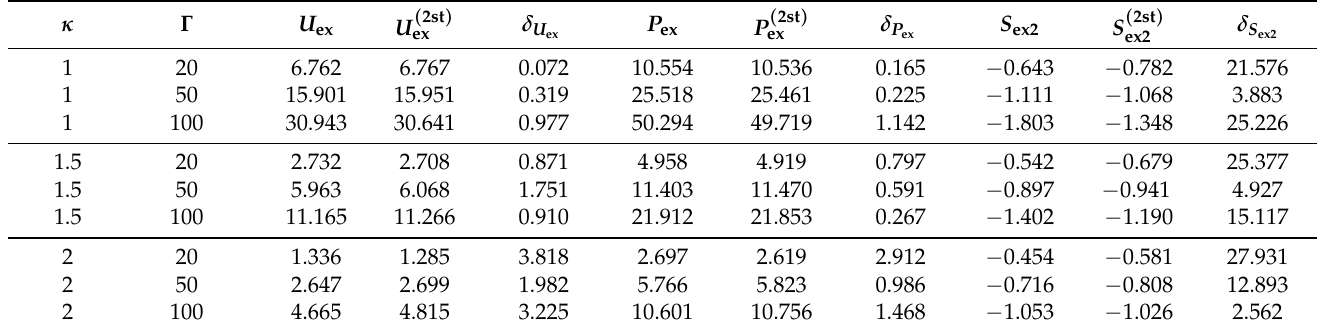
Table 1. Reduced excess internal energy U ex , reduced excess internal pressure P ex , and reduced excess entropy S ex2 of a 2D Yukawa fluid found using g ( x ) from MD simulations. The same quantities ( 2st ) ( 2st ) ( 2st ) ( U ) are calculated based on the expressions (6), (15), and (17). The relative ex , P ex , and S ex2 correspondences δ U , δ P , and δ S of these quantities in % between theoretical results and simula- ex ex ex2 tion